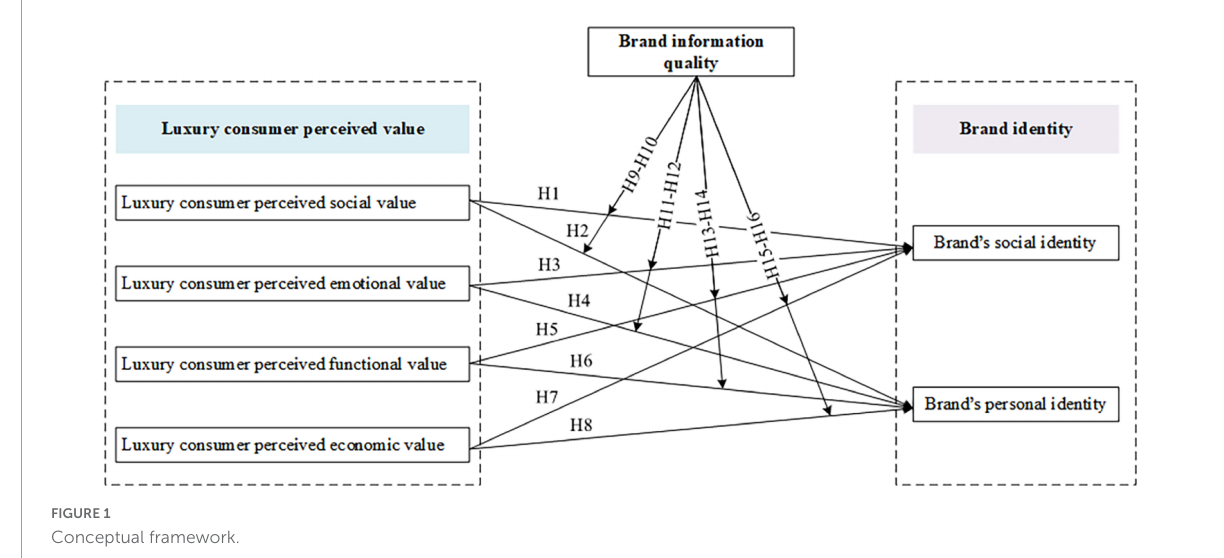
FIGURE1 Conceptual